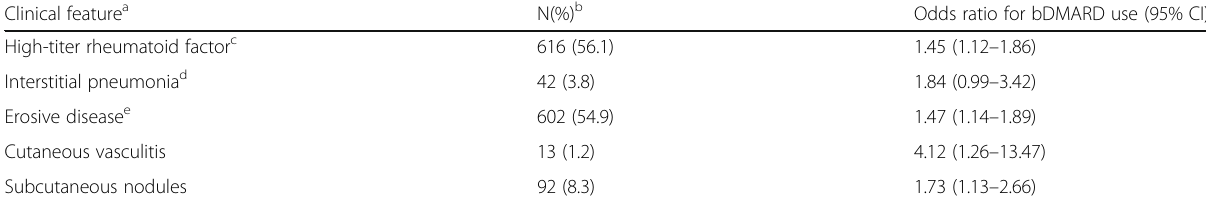
Table 6 Clinical features associated with biological DMARD use Clinical feature